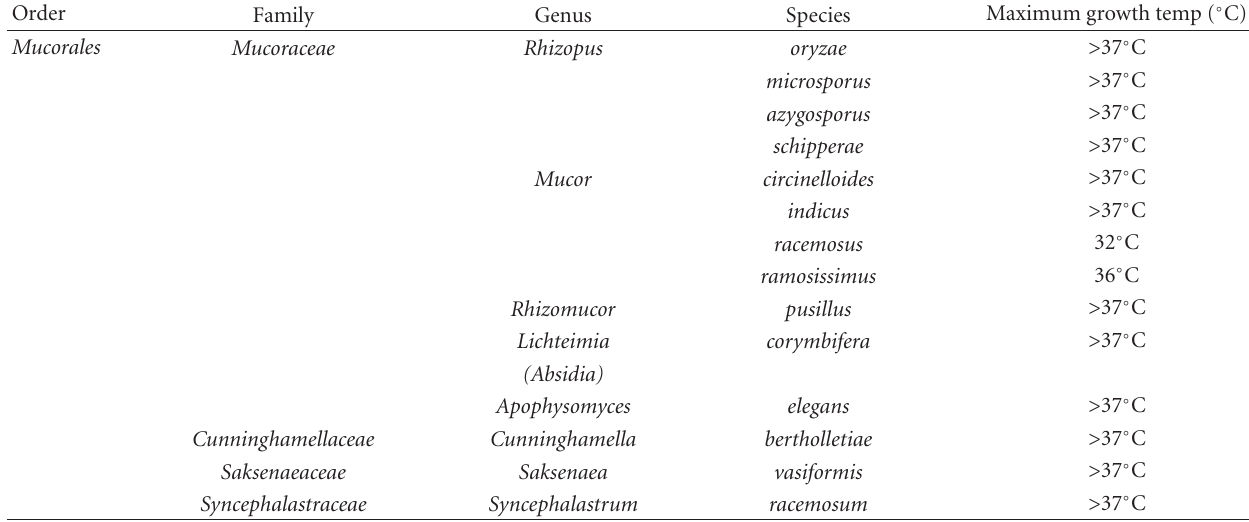
Table 1: Agents a of mucormycosis belonging to Mucorales order of the Glomeromycota